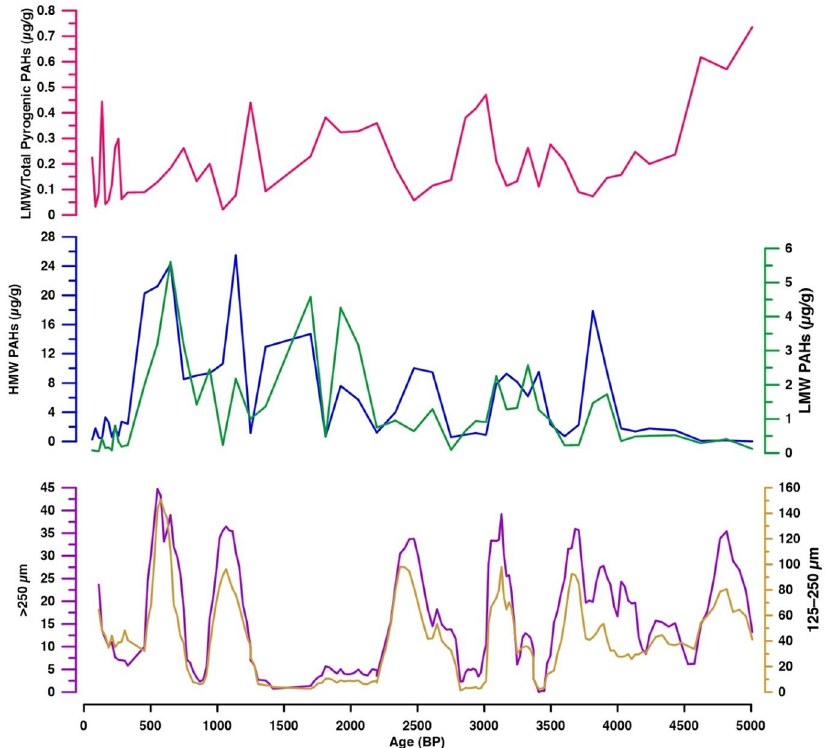
Fig 9. Variations of low-molecular-weight and total pyrogenic PAHs (LMW/Total pyrogenic PAHs), high- molecular-weight (HMW), and low-molecular-weight (LMW) PAHs with comparison to the charcoal abundance (5-point moving